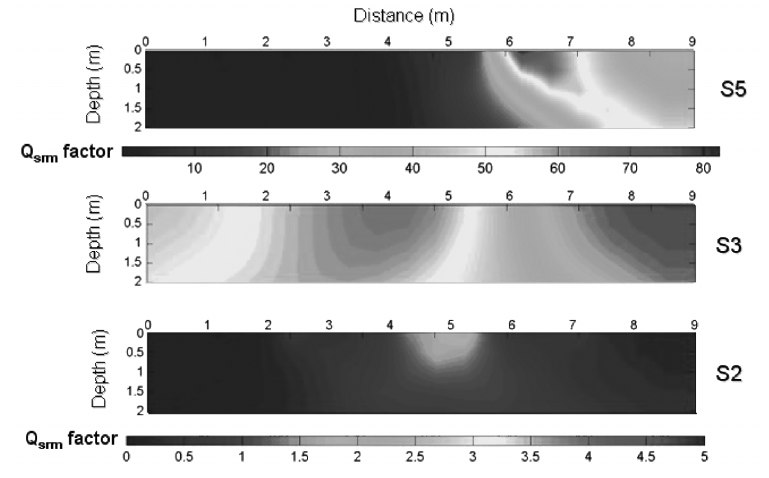
Fig. 9. Q srm -factor models obtained using eq. (2.6).